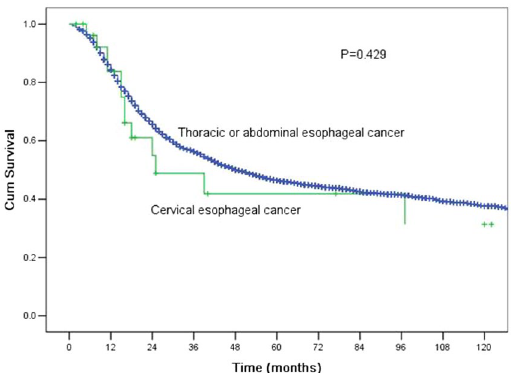
Figure 3. Comparisons of the survival curves for patients with cervical oesophageal cancer and patients with thoracic or abdominal oesophageal cancer who underwent surgery. The median survival time (MST) and the1-, 3-, and 5-year OS rates for CEC patients were 25.0 months (95% confidence interval (CI) 0.8–49.2 months), 83.8%, 48.8%, and 41.9%, respectively, compared with those of 49.0 months (95% CI 43.9–54.1 months), 84.3%, 56.2%, and 46.4% for patients with thoracic or abdominal oesophageal cancer. The survival differences were not statistically significant (P = 0.429).